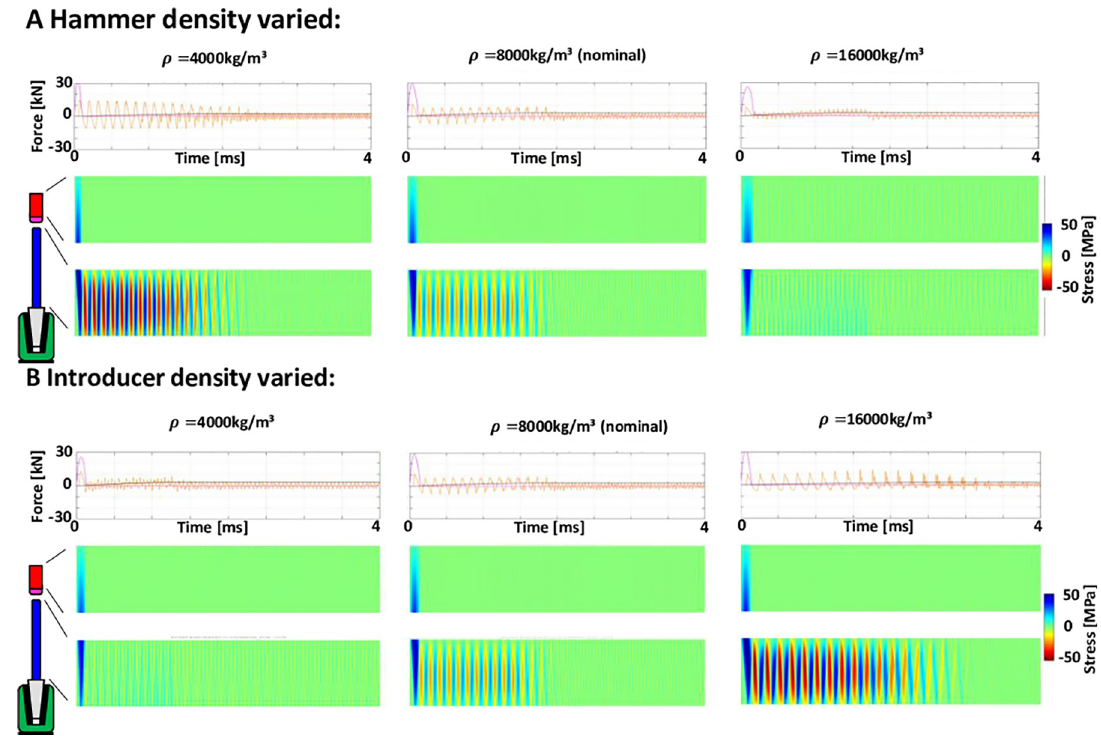
Fig 5. Note: Same colour-coding as Fig 3. A & B graphs: Force outputs are shown over a time period of 4ms. Positive forces are compressive, negative tensile. Contact force between hammer tip and introducer (magenta), force between introducer and implant (orange), seating force of implant in bone (black). A & B contour plots: Stresses along the length of the hammer (Upper) and introducer (Lower) over time.